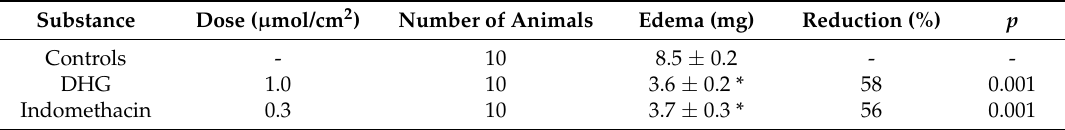
Table 1. Anti-inflammatory activity of DHG in a murine model of dermatitis. Dose-dependent